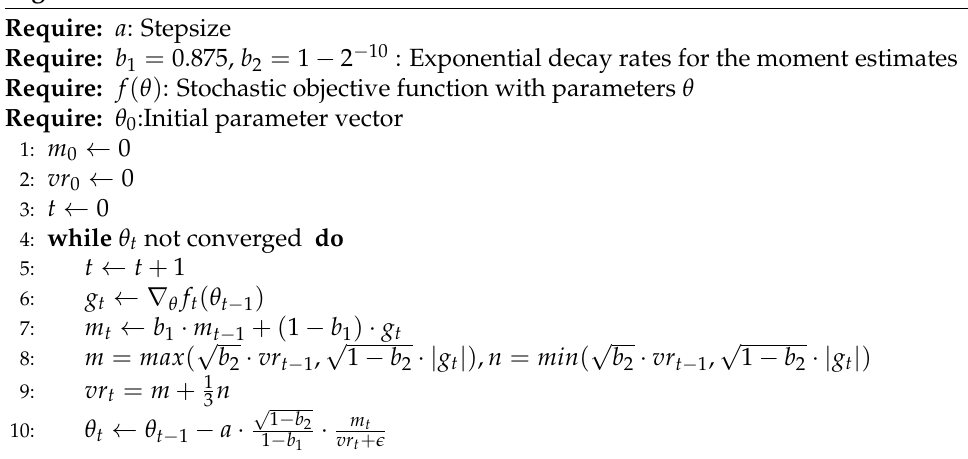
Algorithm 2 The workflow of